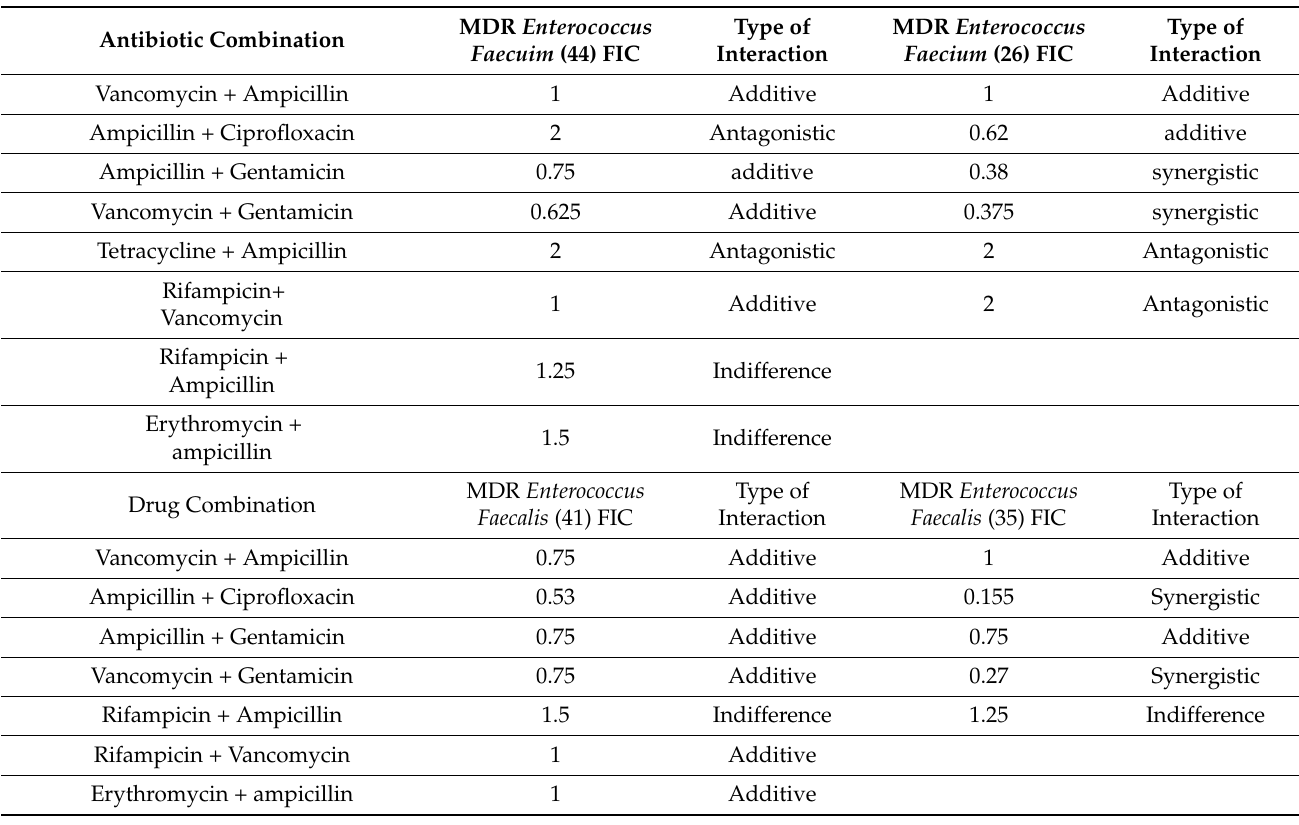
Table 3. FIC values of the combined antibiotics for the test